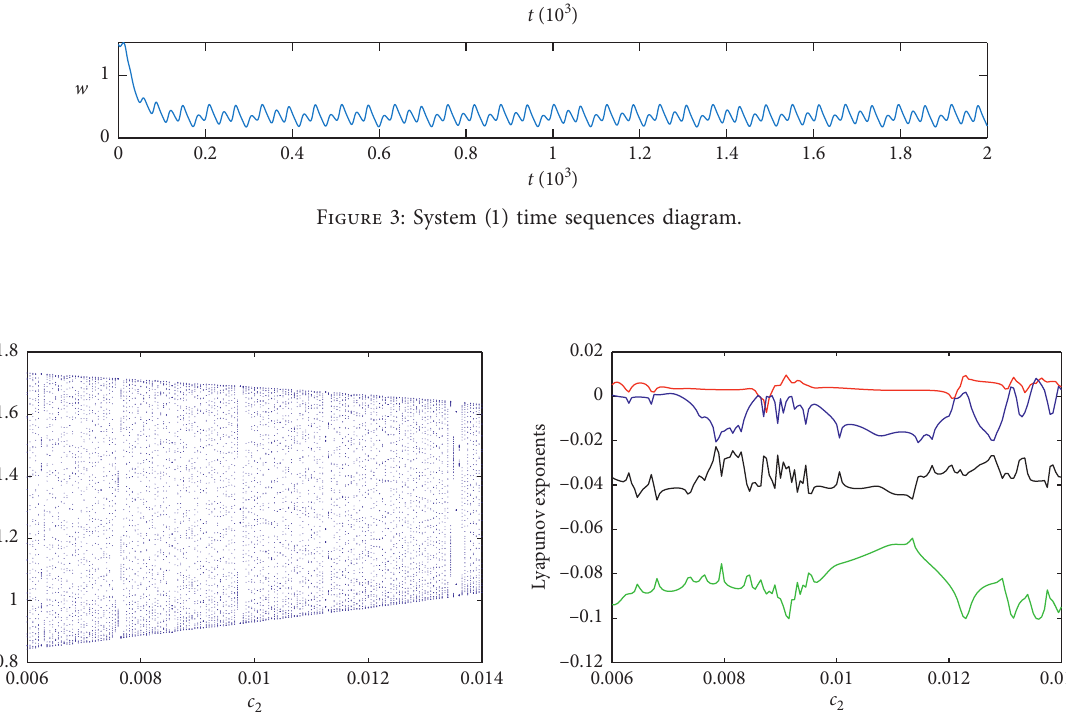
Figure 4: With c ∈ [ 0 . 006 , 0 . 014 ] change system (1): (a) bifurcation diagram; (b) Lyapunov exponential diagram of corresponding 2